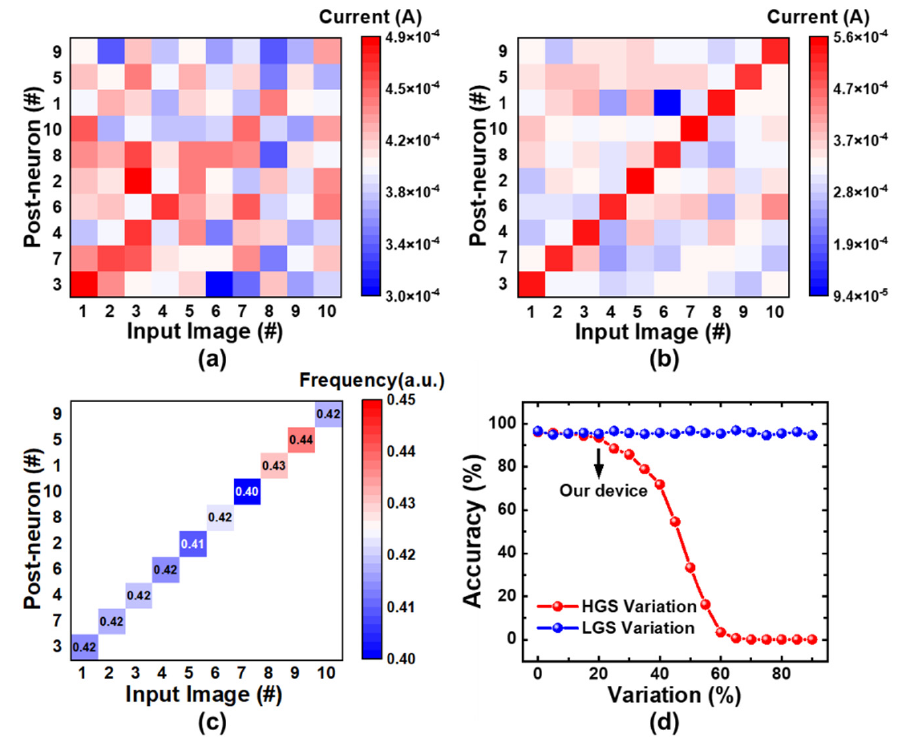
Figure 5. Experimental results of the learned synaptic weights for all digits.